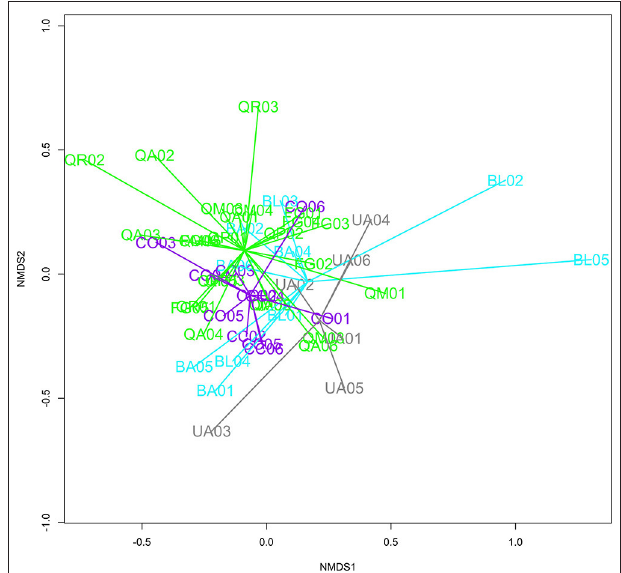
FIGURE 4 | Radar graph for general fungi communities in rhizosphere soils of each of the four experimental plant families at the end of the second growing season. Both conspecific and heterospecific treatments are represented. Families include Fagaceae (Green), Juglandaceae (Purple), Ulmaceae (Gray), and Betulaceae